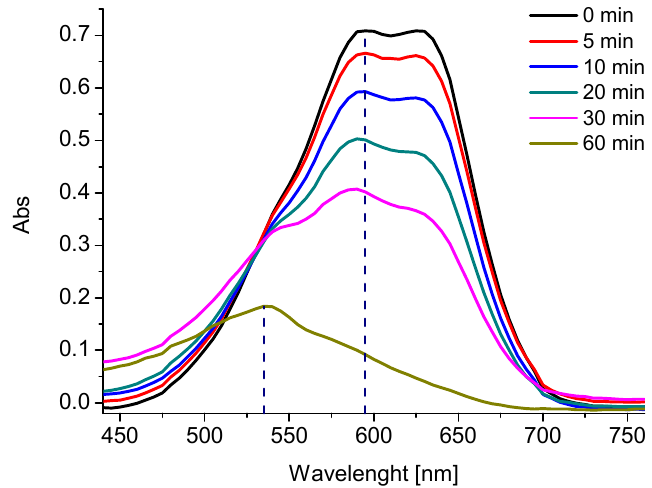
Figure 4. Absorbance spectra of AB129 during decolorization tests (conditions: 25 mg/L AB129, 2.5 mM PDS).